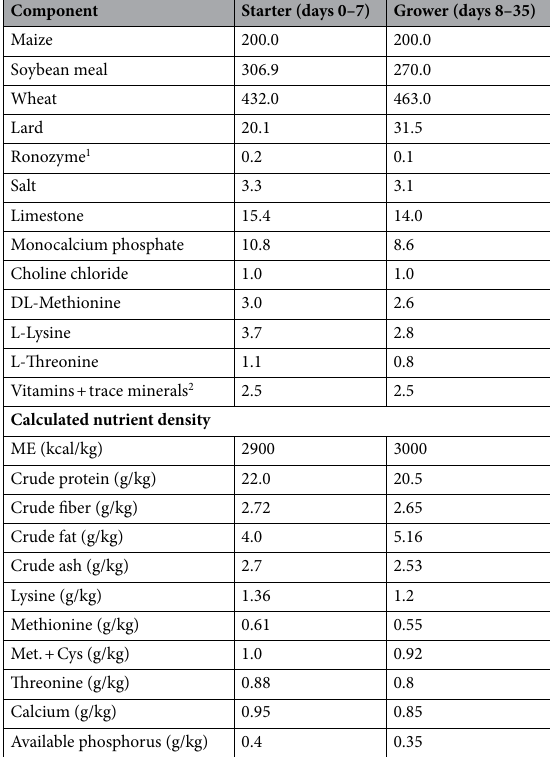
Table 3. Composition of basal diets (g/kg as-is, unless indicated otherwise) fed to broilers over a 35-day feeding period. 1 Ronozyme WX (Novozymes, Copenhagen, Denmark); 360 FXU/kg diet. 2 Provided per kg feed: IU: vit. A. 10,000, vit. D3 4500; mg: vit. E 80, vit. B1 1.5, vit. B2 5, biotin 0.12, vit. B6 2.5, vit. B12 0.02, vit. K33, nicotinic acid 50, folic acid 1.1, pantothenic acid 14, choline 200, betaine 160, Mn 120, Zn 100, Se 0.35, Cu 20, Fe 40, J 3; g: Ca